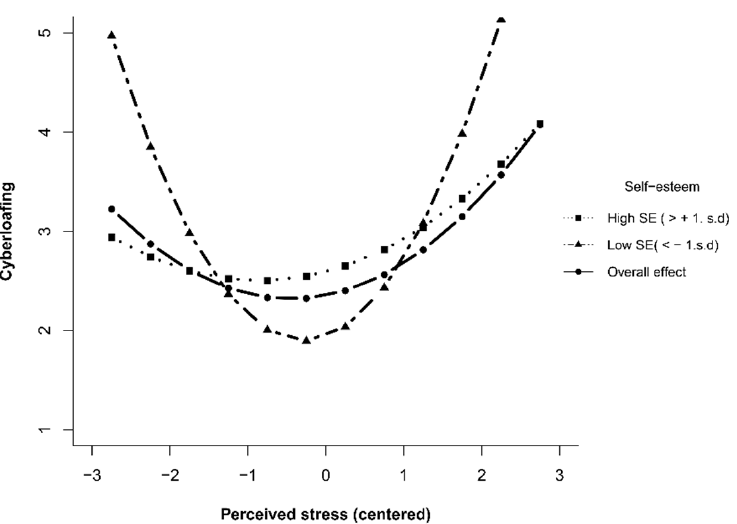
Figure 2. Relationship between perceived stress and cyberloafing as a function of self-esteem. Note. a. SE = self-esteem. b. Over effect means the relationship between perceived stress and cyberloafing in